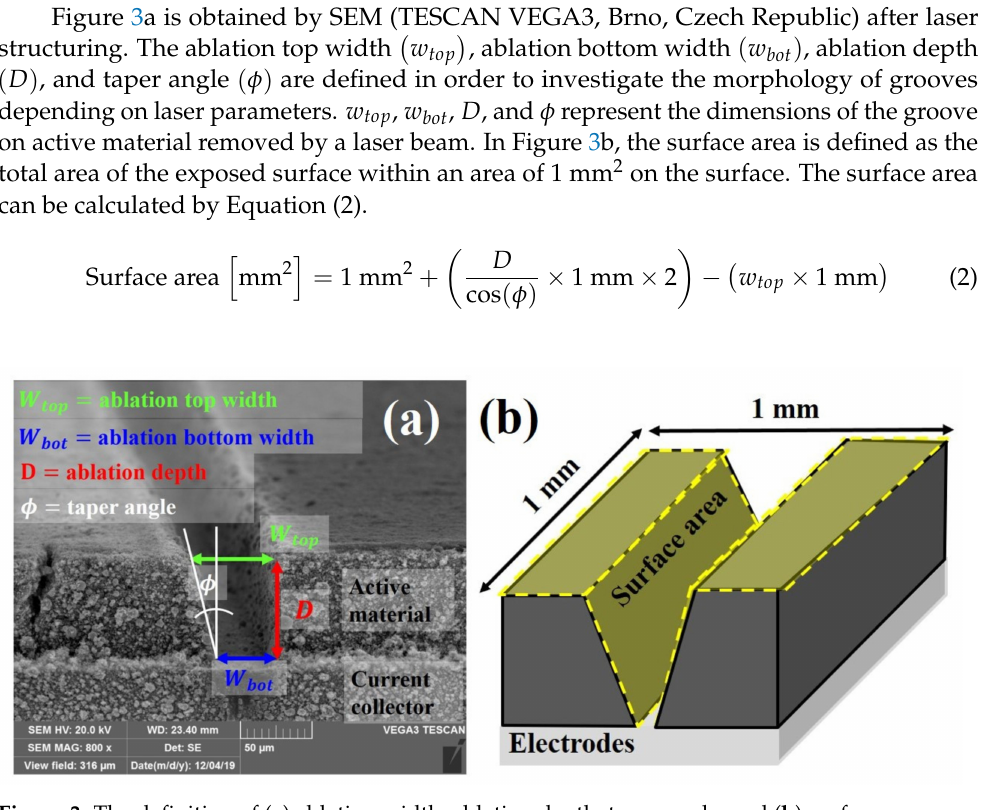
Figure 3. The definition of ( a ) ablation width, ablation depth, taper angle, and ( b ) surface